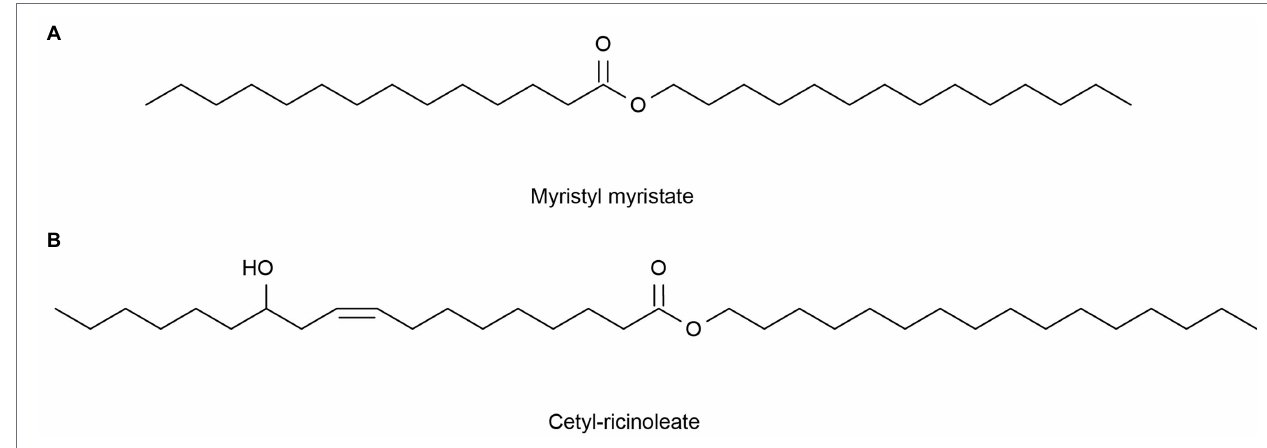
FIGURE 5 | Reprinted with the kind permission of Applied Microbiology and Biotechnology publications (Metzger and Bornscheuer, 2006). Chemical structures of Myristyl myristate (A) and Cetyl-ricinoleate (B) are produced by lipase-catalyzed